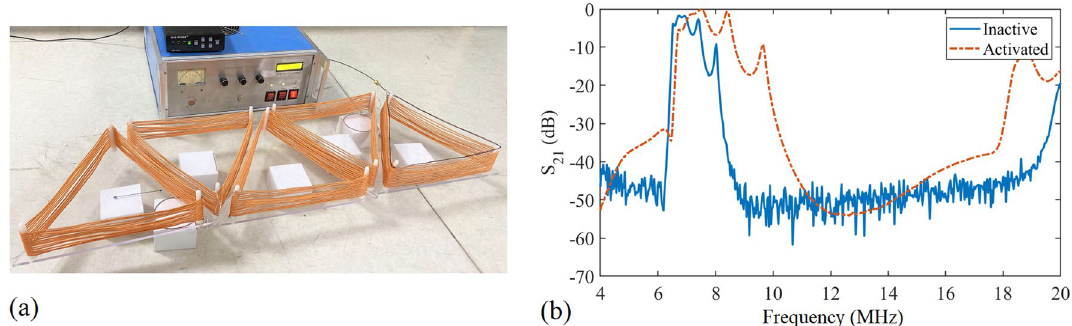
Figure 9. ( a ) Five resonant units with a power source and a transmitting coil. ( b ) Experimental results of S 21 of five inactive units and five activated units.